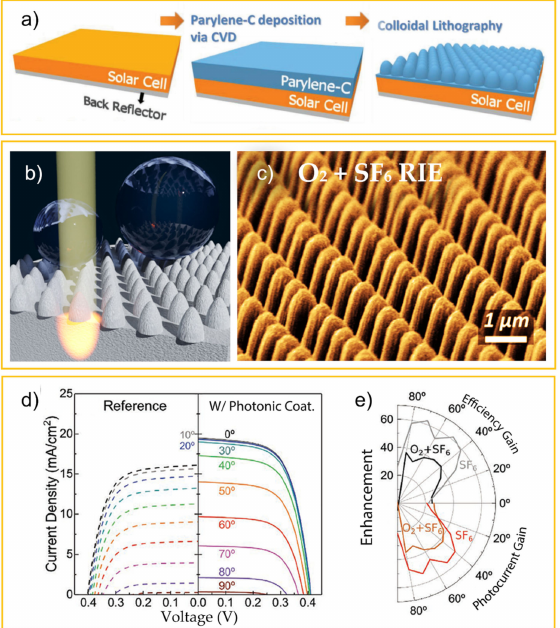
Figure 17. ( a ) Depiction of the patterning of the photonic-structured parylene-C coating on the trans- parent front contact of thin-film silicon solar cells, via chemical vapor deposition (CVD), followed by CL with a patterning approach similar to that of Figure 6b. ( b ) Artistic image of the photonic coating on the solar cell, illustrating its superhydrophobic surface where water droplets easily roll-off. The microstructured parylene-C provides LT while also acting as a water-repellent protective layer, which allows an effective self-cleaning functionality. ( c ) SEM image of the parylene-C surface mi- crostructured via the CL process (O 2 + SF 6 RIE). ( d ) 1-Sun JV curves of the solar cells before (uncoated reference, left curves) and after (right curves) coating with the photonic-structured parylene-C shown in images ( c , d ), for illumination angles varying from 0 ◦ (normal to cell’s surface) to 90 ◦ (parallel to the surface). ( e ) Polar plot presenting the angular dependence of the gain in efficiency (top) and photocurrent (bottom) of the LT-enhanced solar cells relative to the planar references. Adapted with permission from [31]. Copyright 2021 John Wiley and